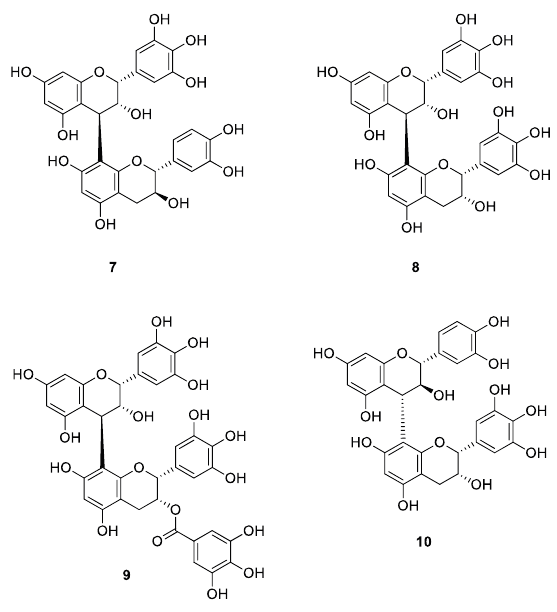
Figure 3. Synthesized dimeric